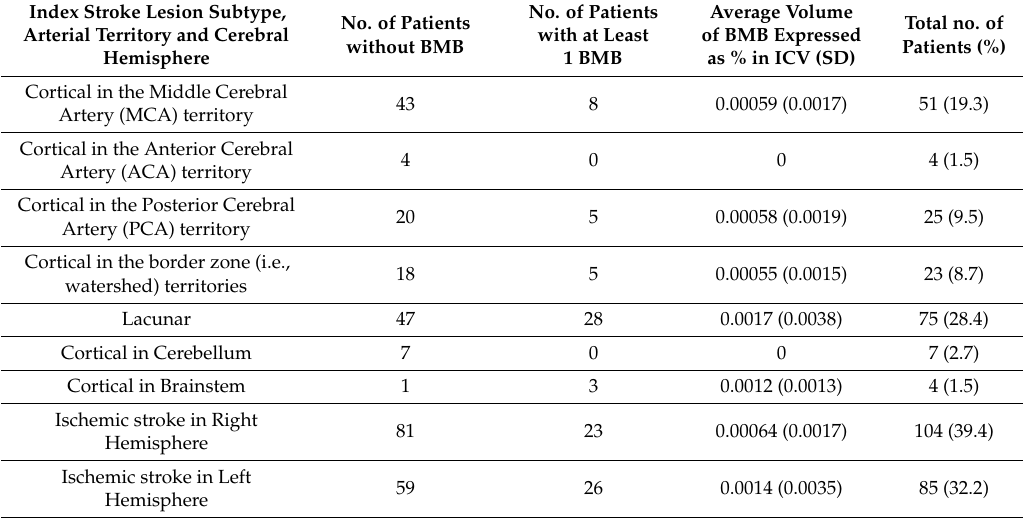
Table 2. Brain microbleed volume and number of patients with vs. without microbleeds per index stroke lesion subtype, cerebral hemisphere and arterial